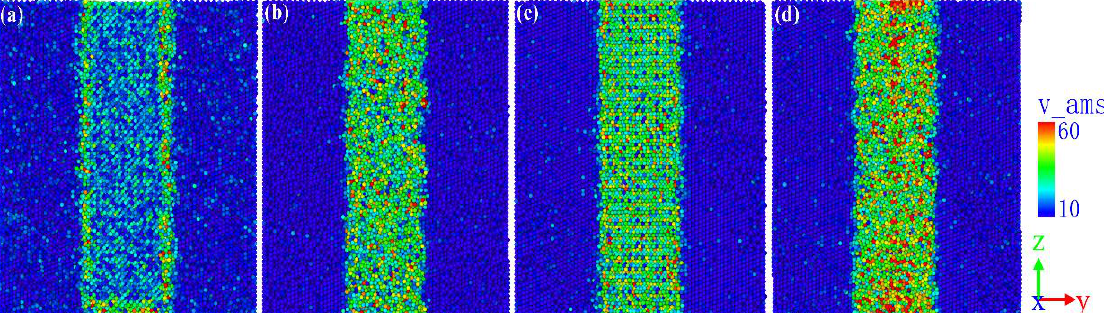
Figure 5. Von-Mises stress distribution in the ( a ) Fe2C model; ( b ) Fe3C model; ( c ) Fe4C model; ( d ) Fe7C3 model.